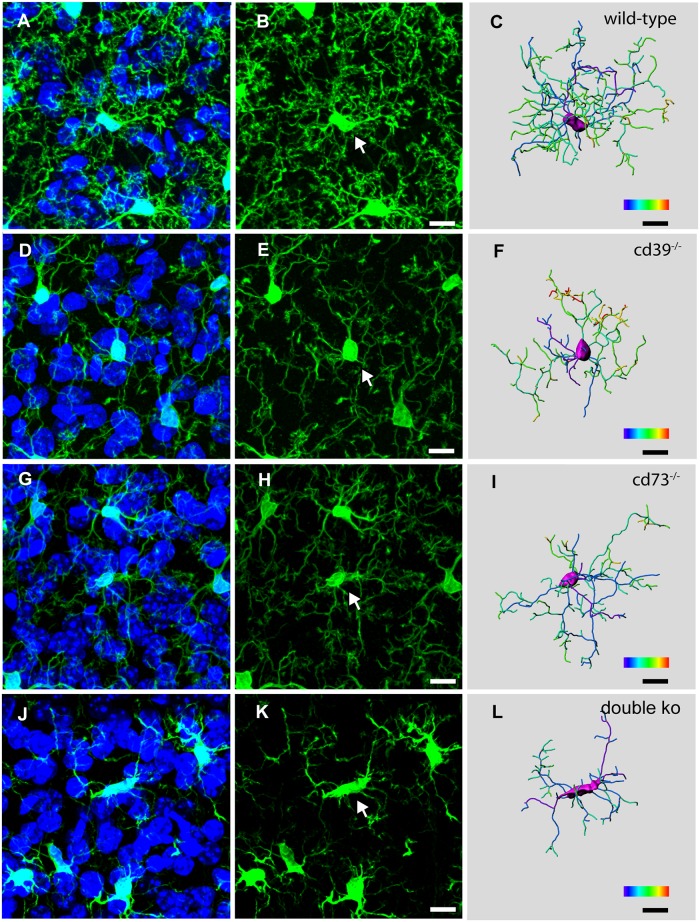
Constitutive deletion of CD39 and/or CD73 attenuates microglial process ramification.Three-dimensional confocal fluorescence images show iba-1/Alexa fluo-488 labelled microglia (left and middle panels) and DAPI-labelled nuclei (left panels), and 3-dimensional reconstruction of an individual microglial cell (right panel) in the somatosensory cortex of wild-type (A—C), cd39-/- (D—F), cd73-/- (G—I) and cd39-/-/cd73-/- (double ko) (J—L) adult (P56) mice are shown; white arrows mark a single microglial cell of which the 3-dimensional reconstructed image is shown in the right panel. Color bar scale decodes the branch level (from 1 to 7) of individual microglial segments. Scale bar denotes 10 μm.